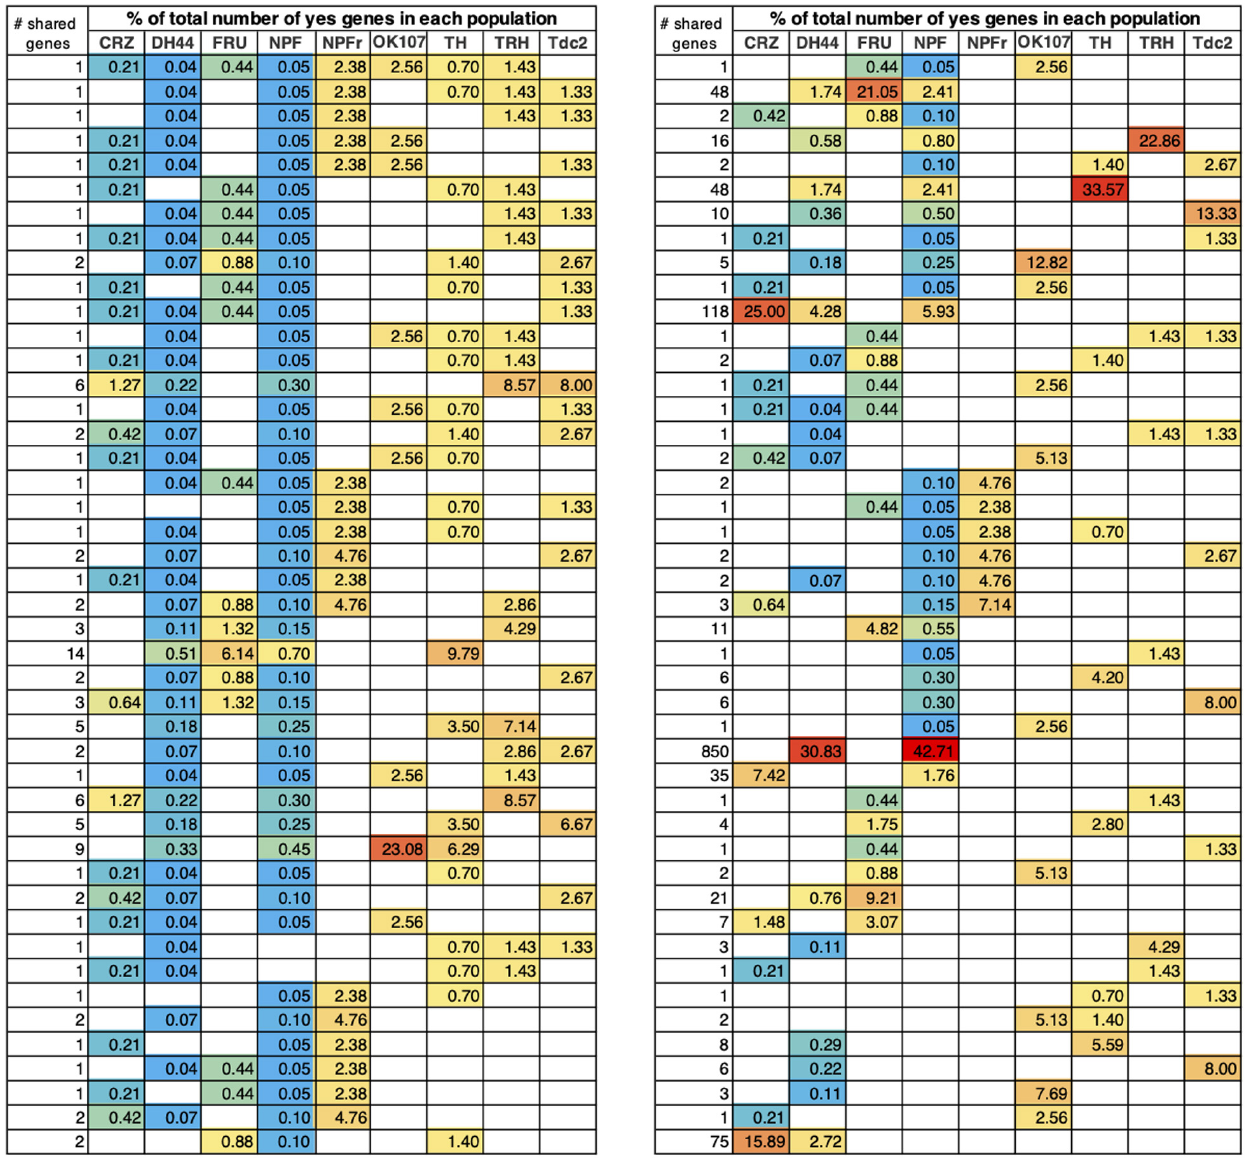
TABLE 1 | The number of shared DEGs varies across